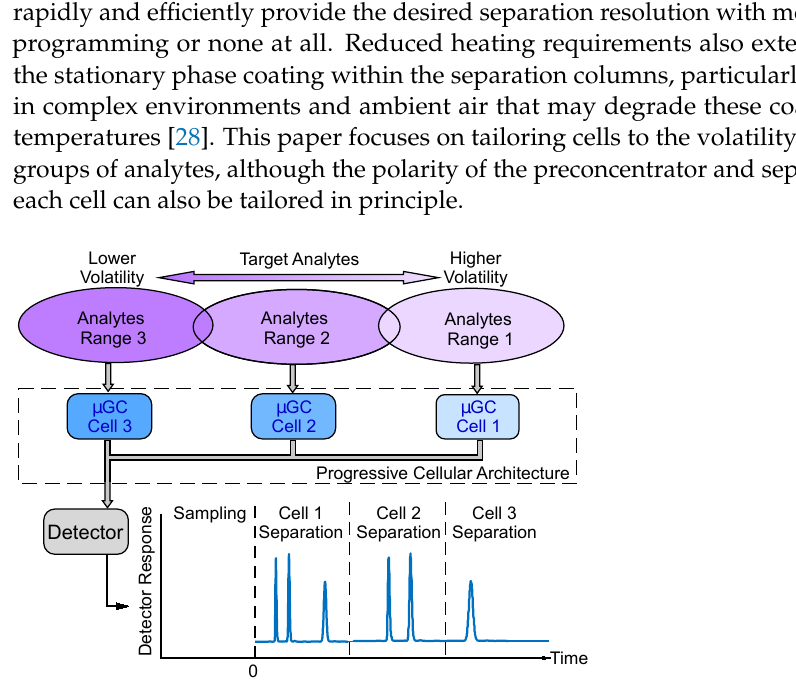
Figure 1. Progressive cellular architecture functional concept and the resulting